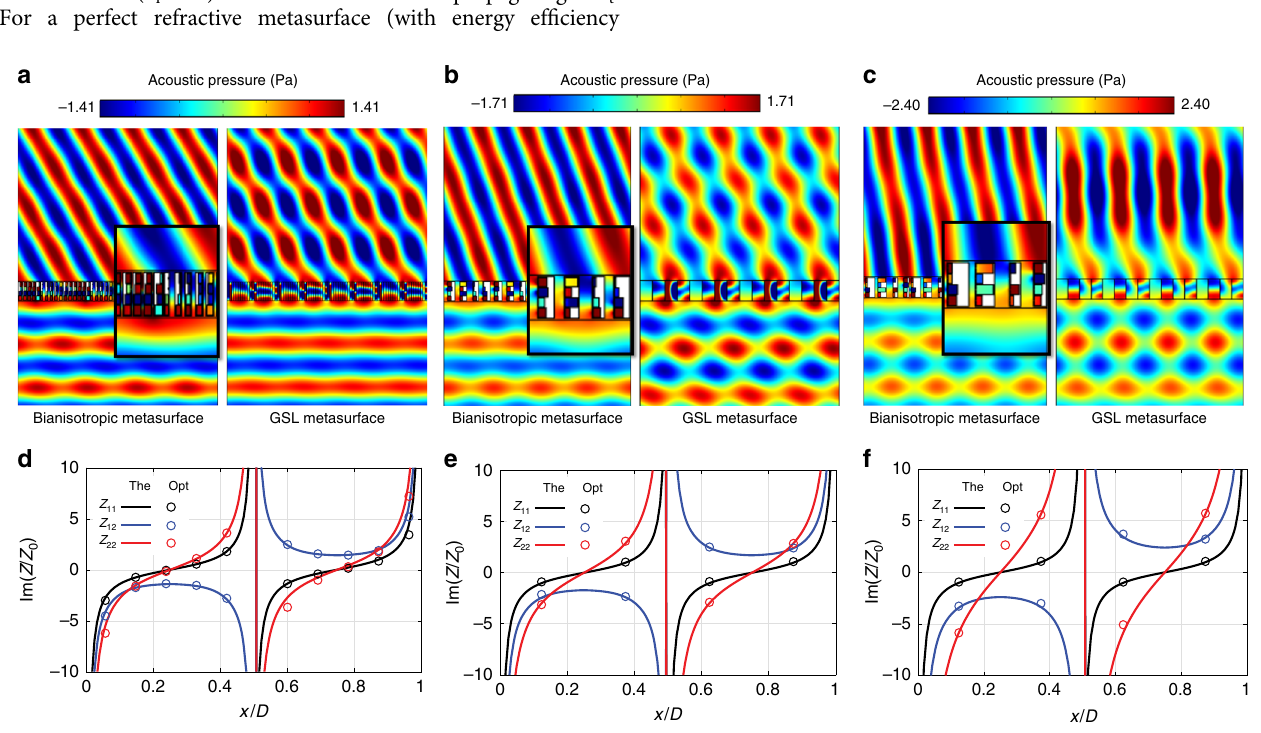
Fig. 3 Bianisotropic metasurfaces for scattering-free anomalous refraction. a – c represent the numerical simulation of the total pressure fi eld for bianisotropic metasurfaces and GSL metasurfaces when θ t = 60°, 70°, and 80°. The insets show the phase evolution inside the metasurface. d – f represent the impedance matrices pro fi le for θ i = 0° and θ t = 60°, 70°, and 80°. Here The denotes theoretical requirements, whereas Opt denotes the impedance values achieved by structure